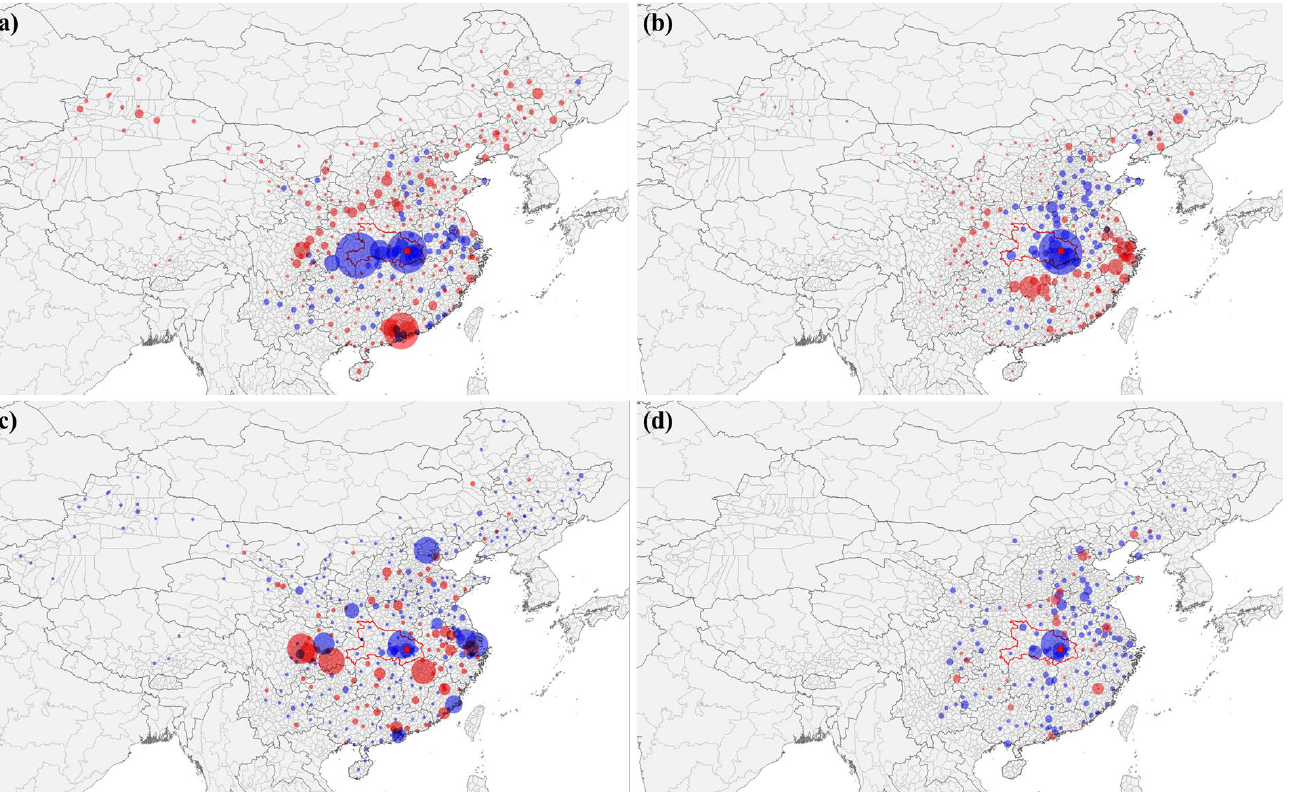
Figure 3. The changes in DAP and PTA after the Wuhan city lockdown. The declining and rising nodal metrics are illustrated by blue and red dots, respectively. The dot size represents the magnitude of the changes in nodal metrics. ( a ) The DAP changes in D-series trains; ( b ) the DAP changes in G-series trains; ( c ) PTA for D-series trains; ( d ) PTA changes for G-series trains.